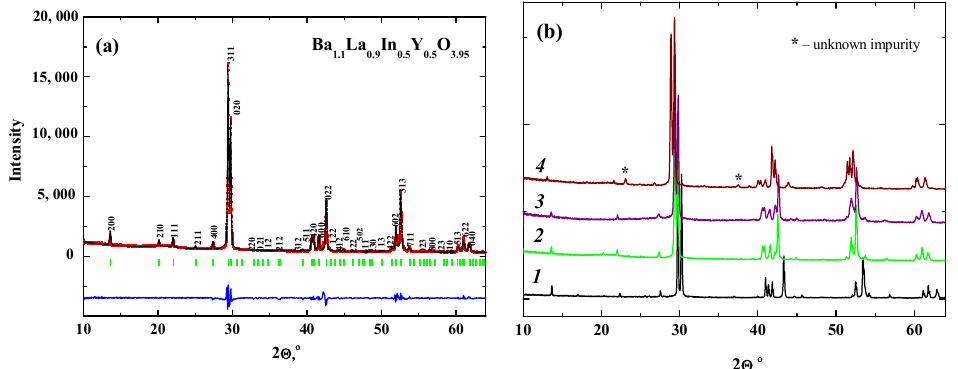
Figure 5. The refinement of XRD-data for the composition Ba 1.1 La 0.9 Y 0.5 In 0.5 O 3.95 ( a ) and the XRD-data for BaLaInO 4 (1), Ba 1.1 La 0.9 Y 0.5 In 0.5 O 3.95 before (2) and after (3) electrochemical measurements and for Ba 1.1 La 0.9 Y 0.6 In 0.4 O 3.95 (4) ( b ). Table 2. The lattice parameters, unit cell volume and amount of water uptake for the samples BaLaInO 4 [24], Ba 1.1 La 0.9 InO 3.95 [24], Ba 1.1 La 0.9 Y 0.5 In 0.5 O 3.95. Sample BaLaInO